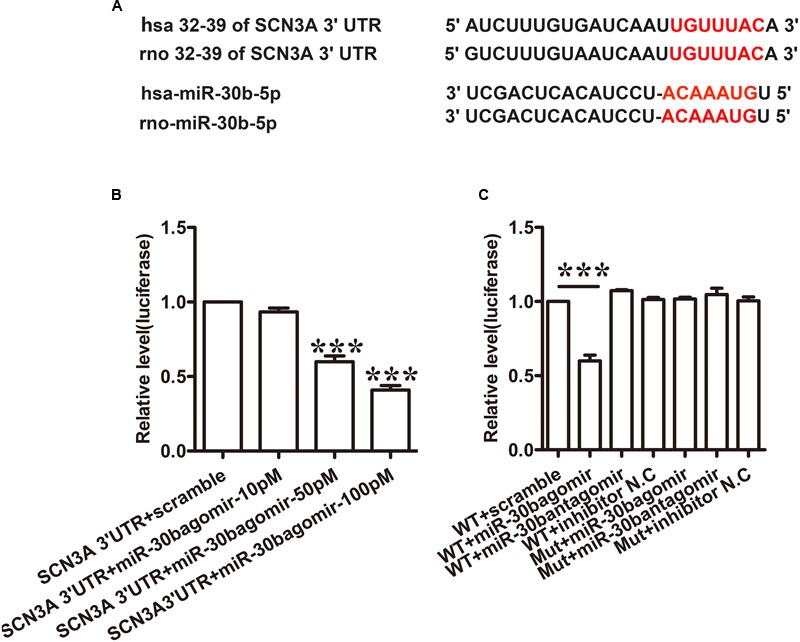
miR-30b directly targets SCN3A 3′UTR. (A) The matched seed region between miR-30b and SCN 3′UTR predicted by Target Scan is in red. (B) MiR-30b agomir decreased relative luciferase activity in a dose-dependent manner with wild-type (WT) SCN3A 3′UTR plasmid vector in PC12 cells, ∗∗∗P < 0.0001 vs. scramble. One-way ANOVA, n = 3. (C) Transfection of miR-30b agomir with WT SCN3A 3′UTR reduced relative luciferase activity, but no change in luciferase activity was detected in the scramble or mutant SCN3A 3′UTR group, ∗∗∗P < 0.0001 vs. WT+ scramble, n = 3. Data are shown as means ± SEM.